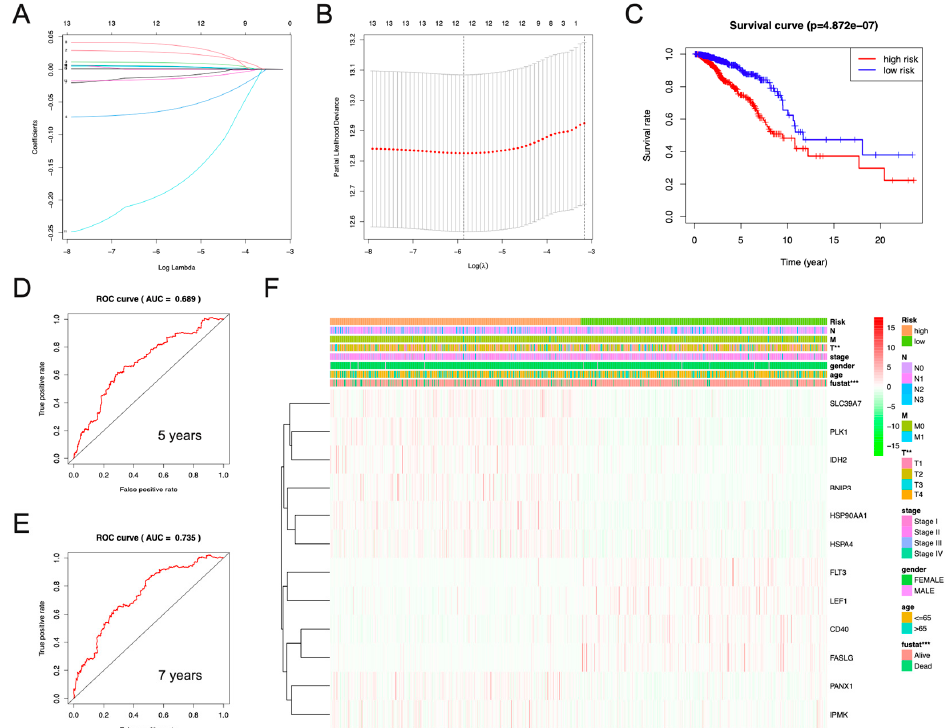
Figure 3. Using necroptosis-related genes to construct risk models and correlations of clinicopatho- logical features in BC. ( A , B ) Lasso coefficients and vertical dashed lines were calculated at the best log (lambda) value, and coefficients of prognostic-related genes were displayed. ( C ) The K-M curve of breast cancer patients showed that the low-risk group had a significantly higher survival rate than the high-risk group based on this necroptosis-related risk model ( p = 4.872e-07). In particular, blue represents the low-risk group and red represents the high-risk group. ( D , E ) ROC curves were drawn based on this necroptosis-related risk model, with AUC values representing 5- and 7-year OS in breast cancer patients. ( F ) The heatmap illustrating the correlation between necroptosis-re- lated risk models and clinicopathological characteristics of breast cancer patients. ** p < 0.01; *** p < 0.001